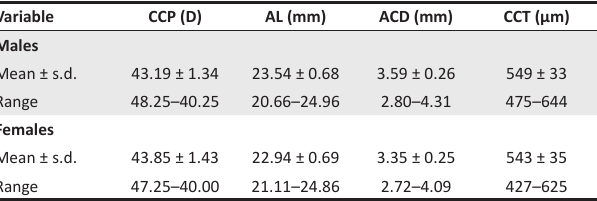
TABLE 1: Characteristics for 200 students (97 males and 103 females), aged 18–23